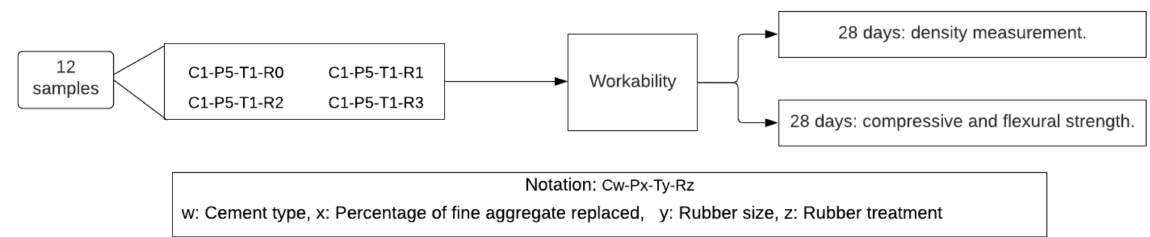
Figure 3. Experimental plan description of stage